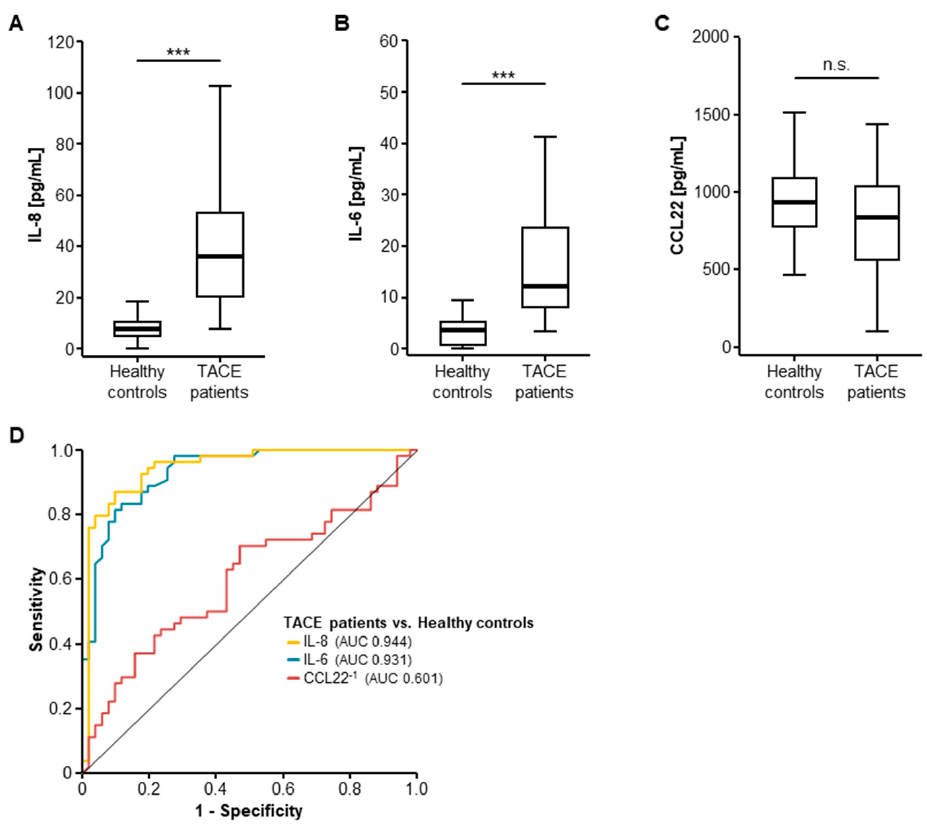
Figure 1. Serum levels of IL-6 and IL-8 but not CCL22 are elevated in patients with hepatic malignancies. ( A , B ) Pre-interventional serum concentrations of IL-8 and IL-6 are significantly elevated in patients with primary and secondary liver cancer; ( C ) Serum levels of CCL22 are unaltered between these patients and healthy controls; ( D ) ROC curve analysis shows AUCs of 0.944 and 0.931 for IL-8 and IL-6 regarding the discrimination between TACE patients and healthy controls. (* p < 0.05; ** p < 0.01; *** p < 0.001; n.s.: p > 0.05).